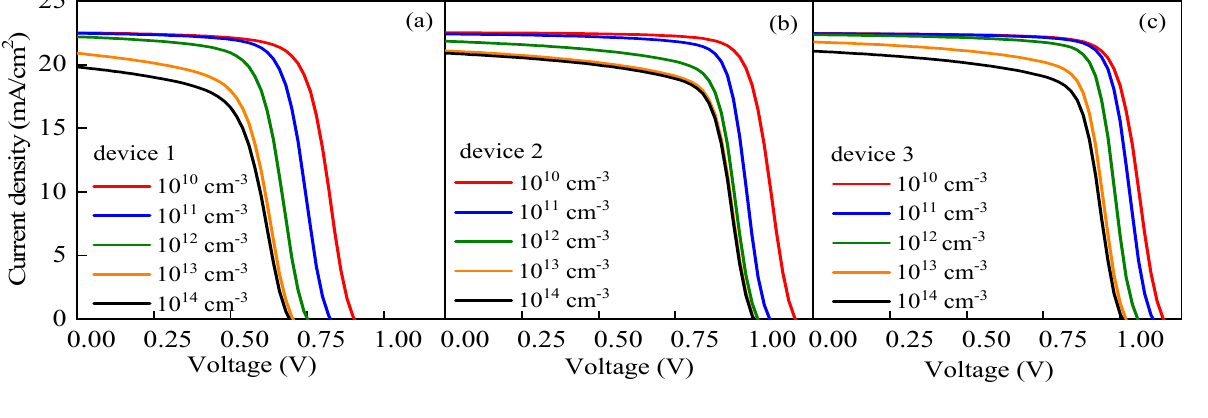
Figure 15. Effects of N it on the cell performance: ( a ) effect of N it on J-V characteristic curve of device 1, ( b ) effect of N it on J-V characteristic curve of device 2, and ( c ) effect of N it on J-V characteristic curve of device 3.